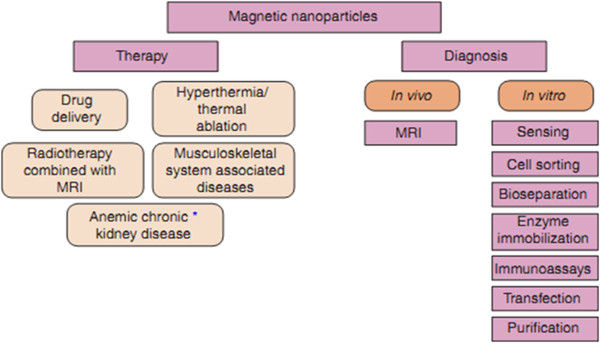
Applications of superparamagnetic iron oxide nanoparticles (SPION)10.